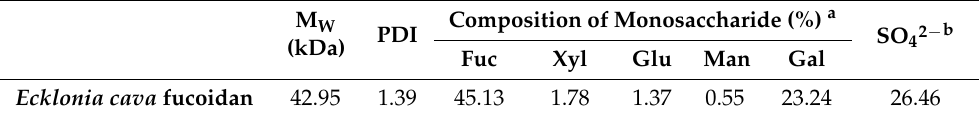
Table 1. The component analysis of Ecklonia cava fucoidan (ECF). The molecular weight (M w ) was determined by gel permeation chromatography (GPC). The monocyte composition of ECF has analyzed by HPLC. Turbidimeric assay was conducted for determination of SO 42 − in ECF. The numbers show the percentage of the component in the ECF. Composition of Monosaccharide (%) a M W PDI SO 42 − b (kDa) Fuc Xyl Glu Man Gal Ecklonia cava fucoidan 42.95 1.39 45.13 1.78 1.37 0.55 23.24